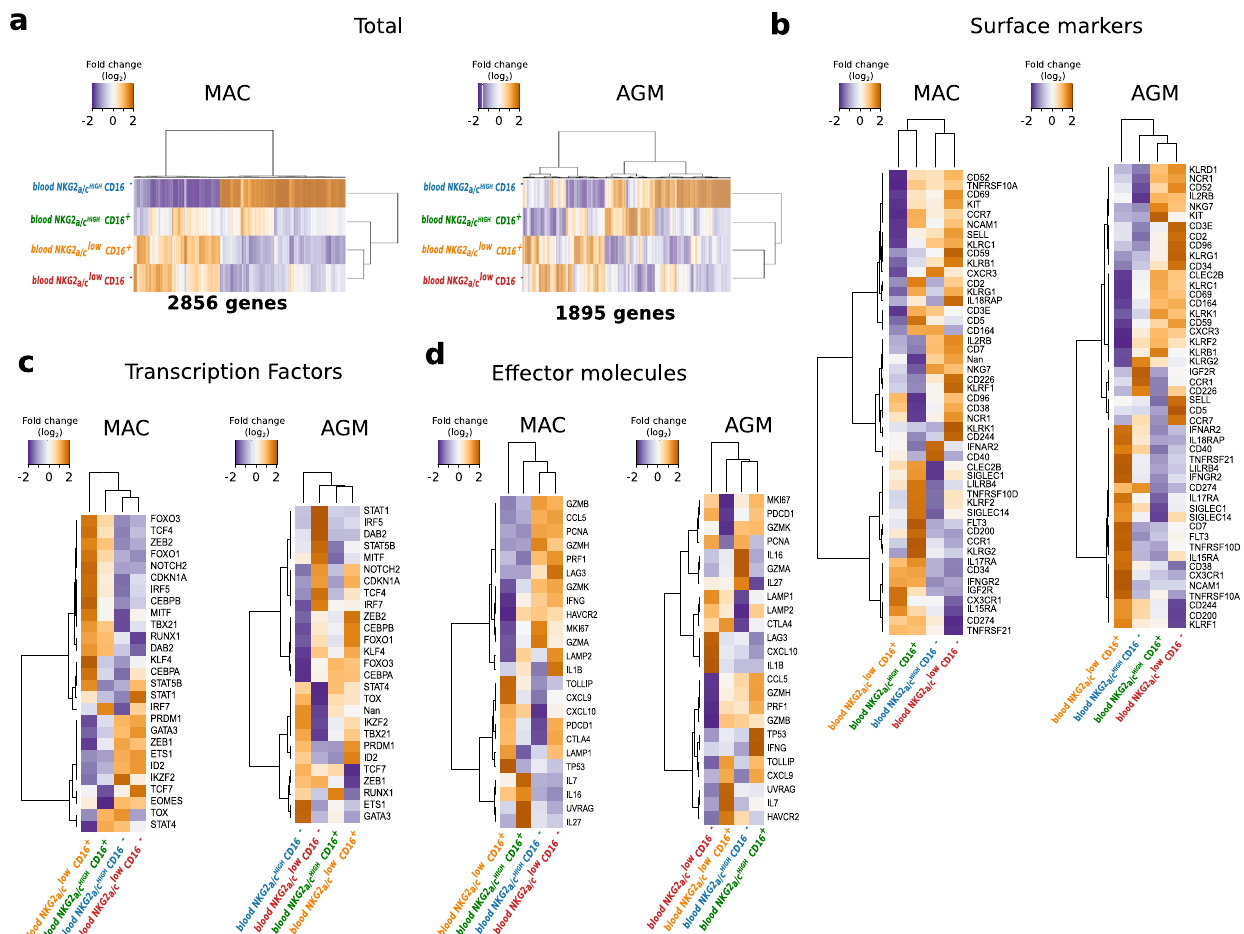
Fig. 2 Genome-wide transcriptional and functional analysis of blood NK cells during SIV infection in the natural and heterologous hosts. a – d Heatmaps of the RNA-seq transcript signatures for a total, b NK cell surface markers, c transcription factors, and d effector molecules in blood. The orange and blue colors indicate higher and lower levels of transcripts measured in NK cell subsets from three chronically infected monkeys per species. Each row represents a transcript showing a signi fi cant change, and each column represents the median of three chronically infected monkeys. In each panel, NK cell subsets are organized based on the overall similarity in gene expression patterns by an unsupervised hierarchical clustering algorithm of variable genes. A dendrogram, in which the length of the branches re fl ects the comparative difference in gene expression pro fi les between each of the NK samples is shown. A p -value adjustment was performed to account for multiple comparisons and control the false positive rate to a chosen level. P values ≤ 0.05 were considered statistically signi fi cant. The transcriptome similarity among clusters of the blood sample was evaluated by the Euclidean distance. In panel b – d the name of the proteins coding by the transcripts are indicated. Source data been deposited in the Gene Expression Omnibus database; the accession number is